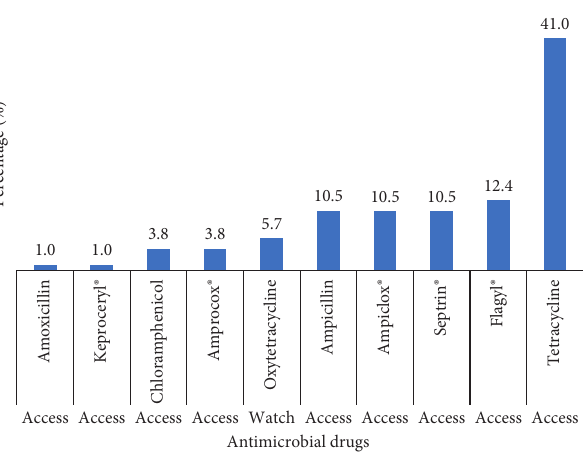
Figure 1: Antimicrobial drugs commonly used by farmers. Tet- racycline is the most commonly used antimicrobial drug ( n � 212).